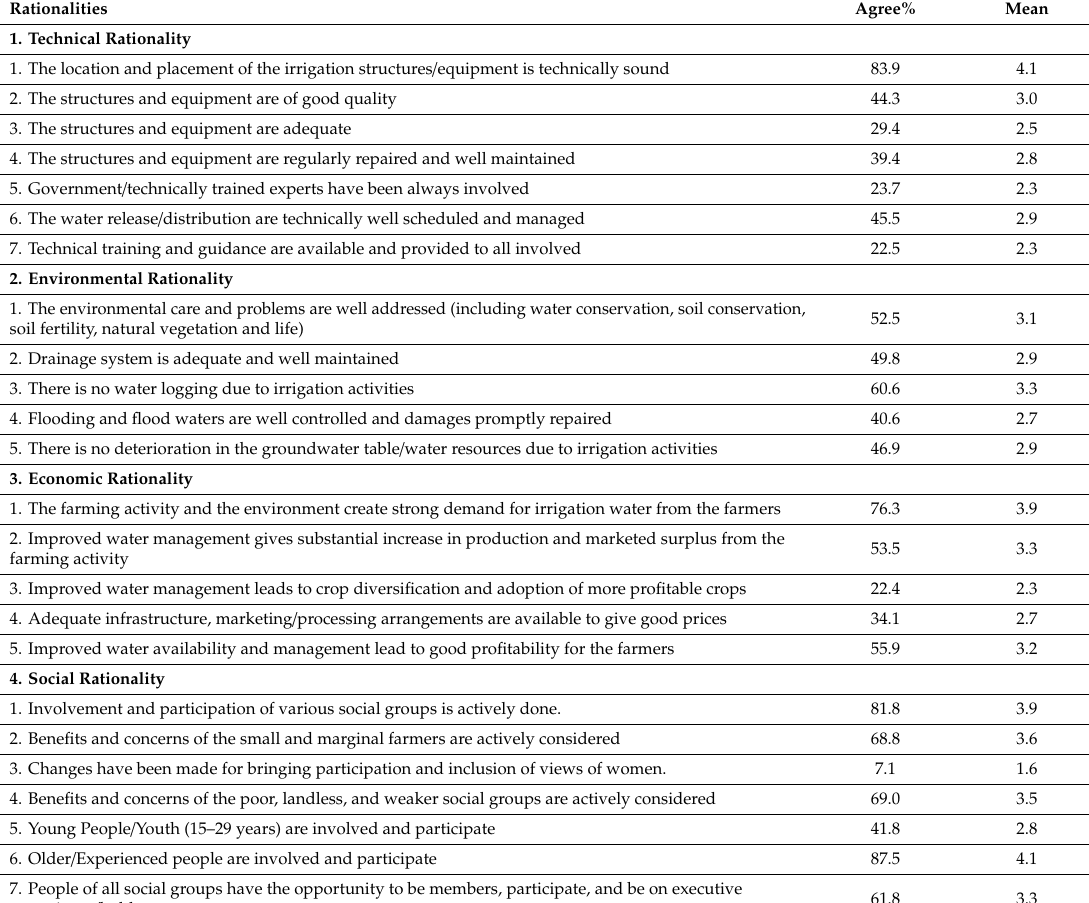
Table 6. Assessment of rationalities—percent